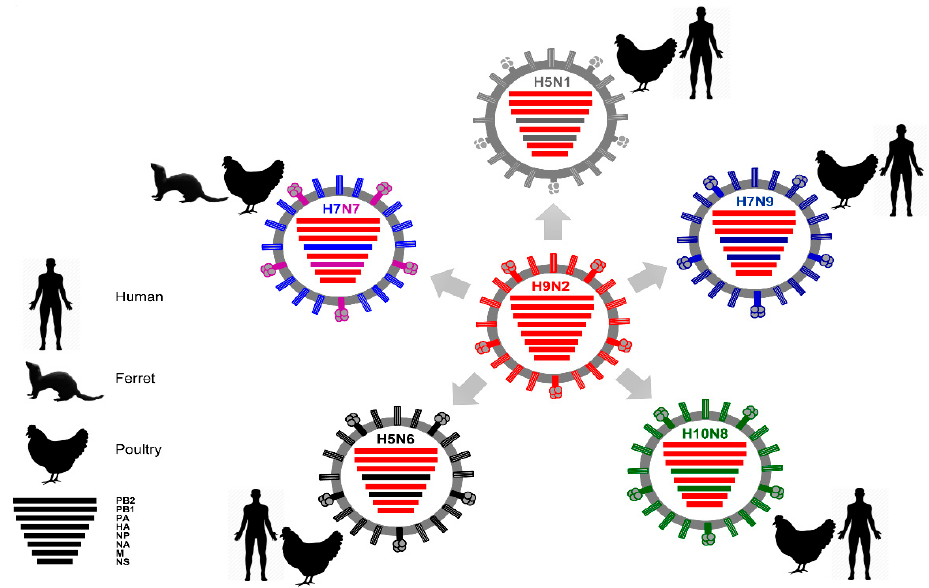
Figure 6. H9N2-type influenza A viruses donate their internal genes to other IAVs. Recent studies revealed the contribution of the internal genes of H9N2 in the genesis of various, recently evolved AIV strains with zoonotic potential [135,138,139]. Poultry (chicken pictogram) served as mixing hosts for emergence of these influenza reassortants, which are then transmitted naturally to humans (human pictogram), or evaluated experimentally in ferrets (ferret pictogram), leading to infections/deaths.